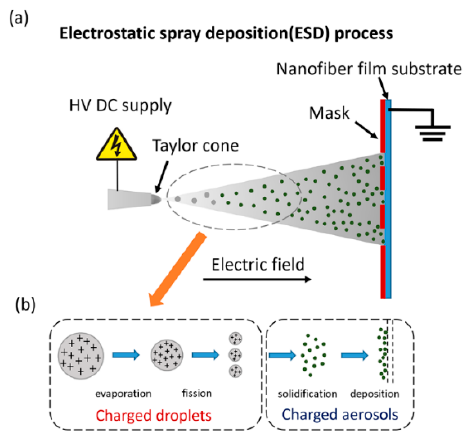
Figure 2 . ( a ) Schematic diagram of electrostatic spray deposition; ( b ) Schematic diagram of charged aerosols generation and deposition process.